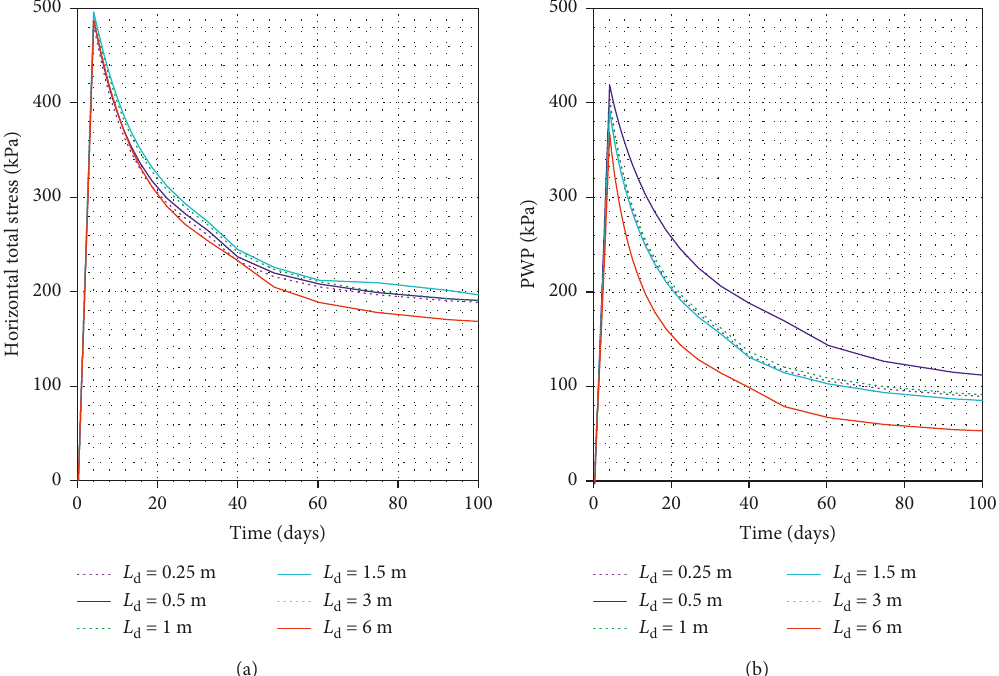
Figure 15: Evolution of the (a) horizontal total stress σ h and (b) PWP u w at midheight of the barricade, from the start of stope filling when the barricade is positioned in the drift at different distances from the stope entrance (see the details in Table 1, Case 6).